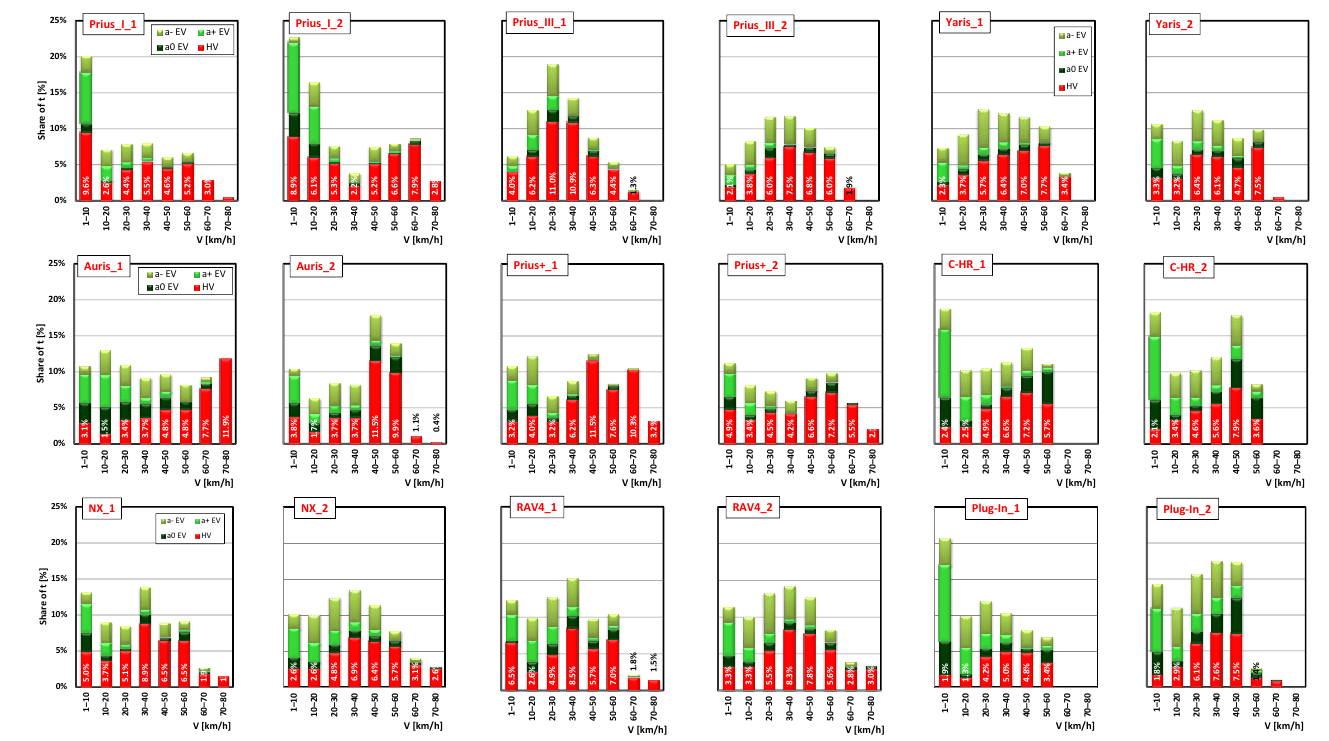
Figure 11. Interval analysis of speed under hybrid and electric driving conditions of the tested vehicles.